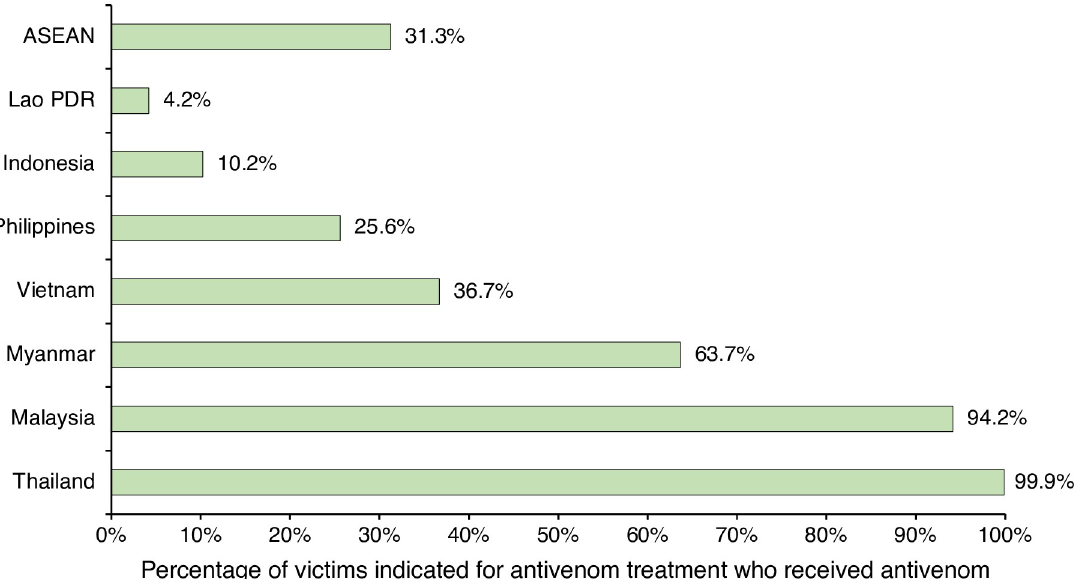
Fig 3. Estimated proportions of snakebite victims treated with antivenom in ASEAN countries. Percentages are estimated from number of snakebite victims treated with antivenom divided by total number of snakebite victims with systemic envenoming who need antivenom; Main sources of information were national statistics and published research for the burden estimation of Malaysia, Thailand, and Myanmar. Published research and anecdotal evidence (local data, and expert opinion) were the main sources of information for the burden estimation of Vietnam, and Lao PDR. Anecdotal evidence was the only source of information for the burden estimation of Indonesia, and Philippines.